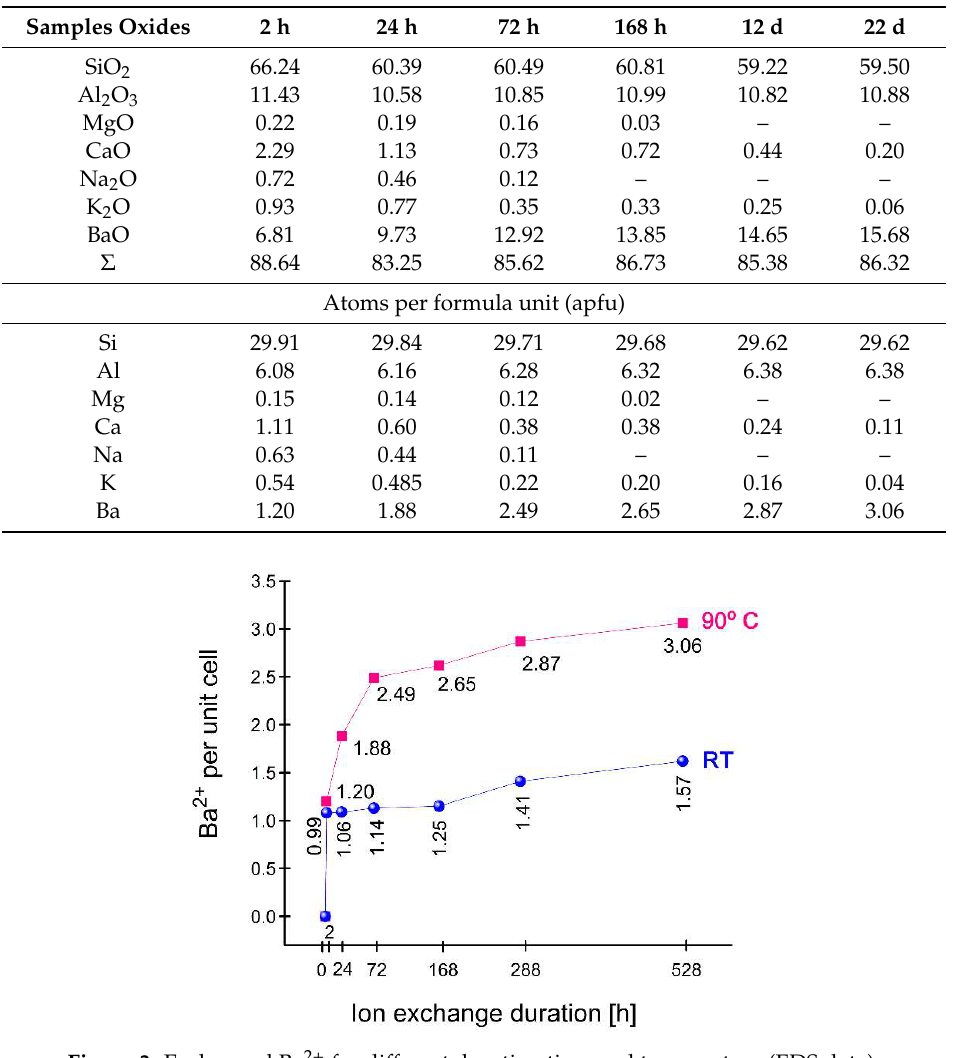
Table 2. Chemical composition (EDS, wt%) and structural formulae of Ba-clinoptilolite (90°) based on 72 oxygen atoms.